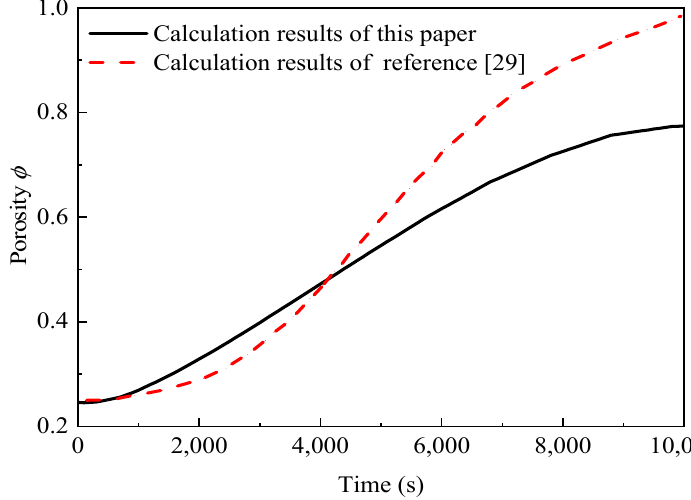
Figure 5. Evolution curves of porosity at inner boundary.